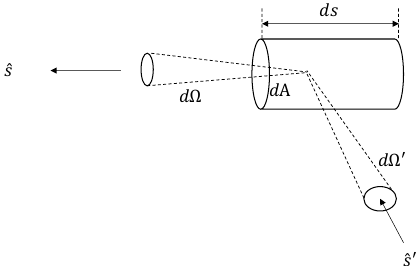
Figure 6. Illustration of the elementary scattering volume for Equation